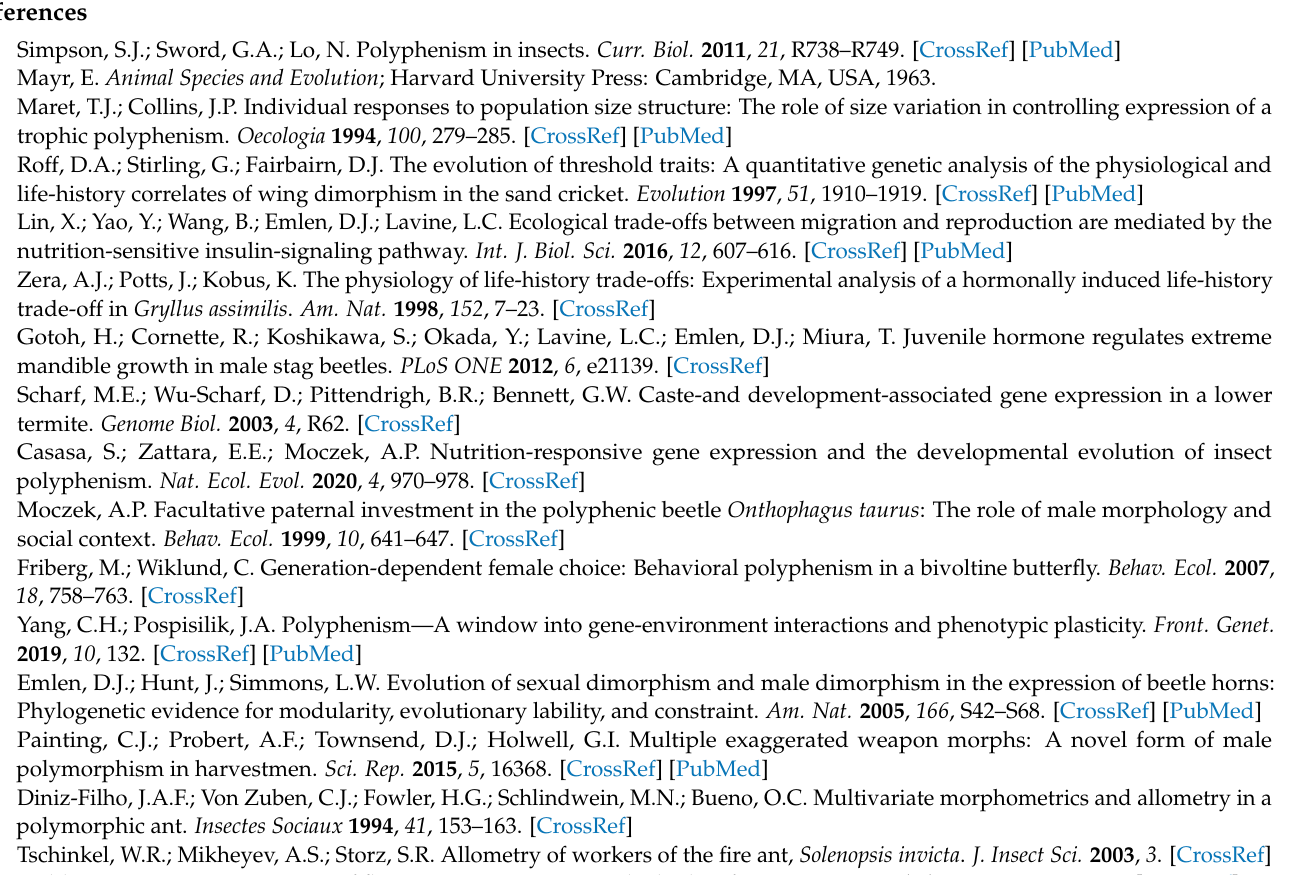
directional asymmetry; Table S1: ANOVA results of size analyses; Table S2: Descriptive statistics of assumptions; Table S3: ANOVA results of corrected FA analyses; Table S4: Correlation between percentage body fat and FA traits; and Table S5: Results of GMM analyses on forewing